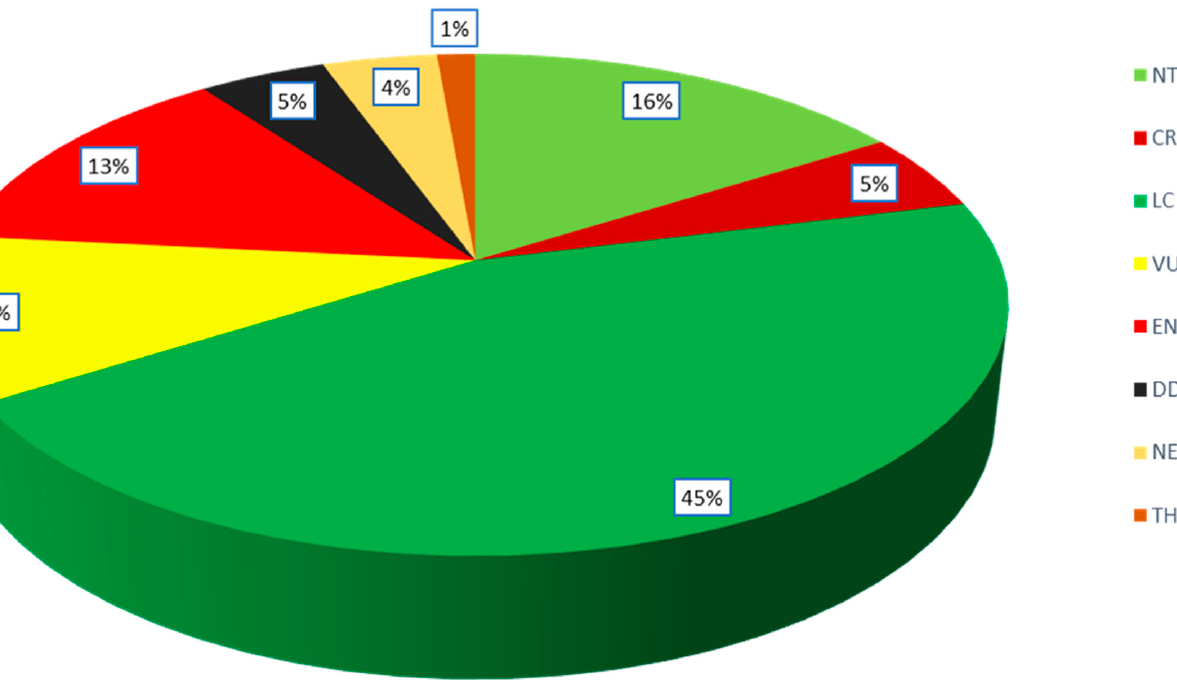
Figure 5. The proportion of current IUCN conservation status of Podocarpaceae species. The conservation status is evaluated according to IUCN Red List categories and criteria, version 3.1 (IUCN Council, Geneva, Switzerland).